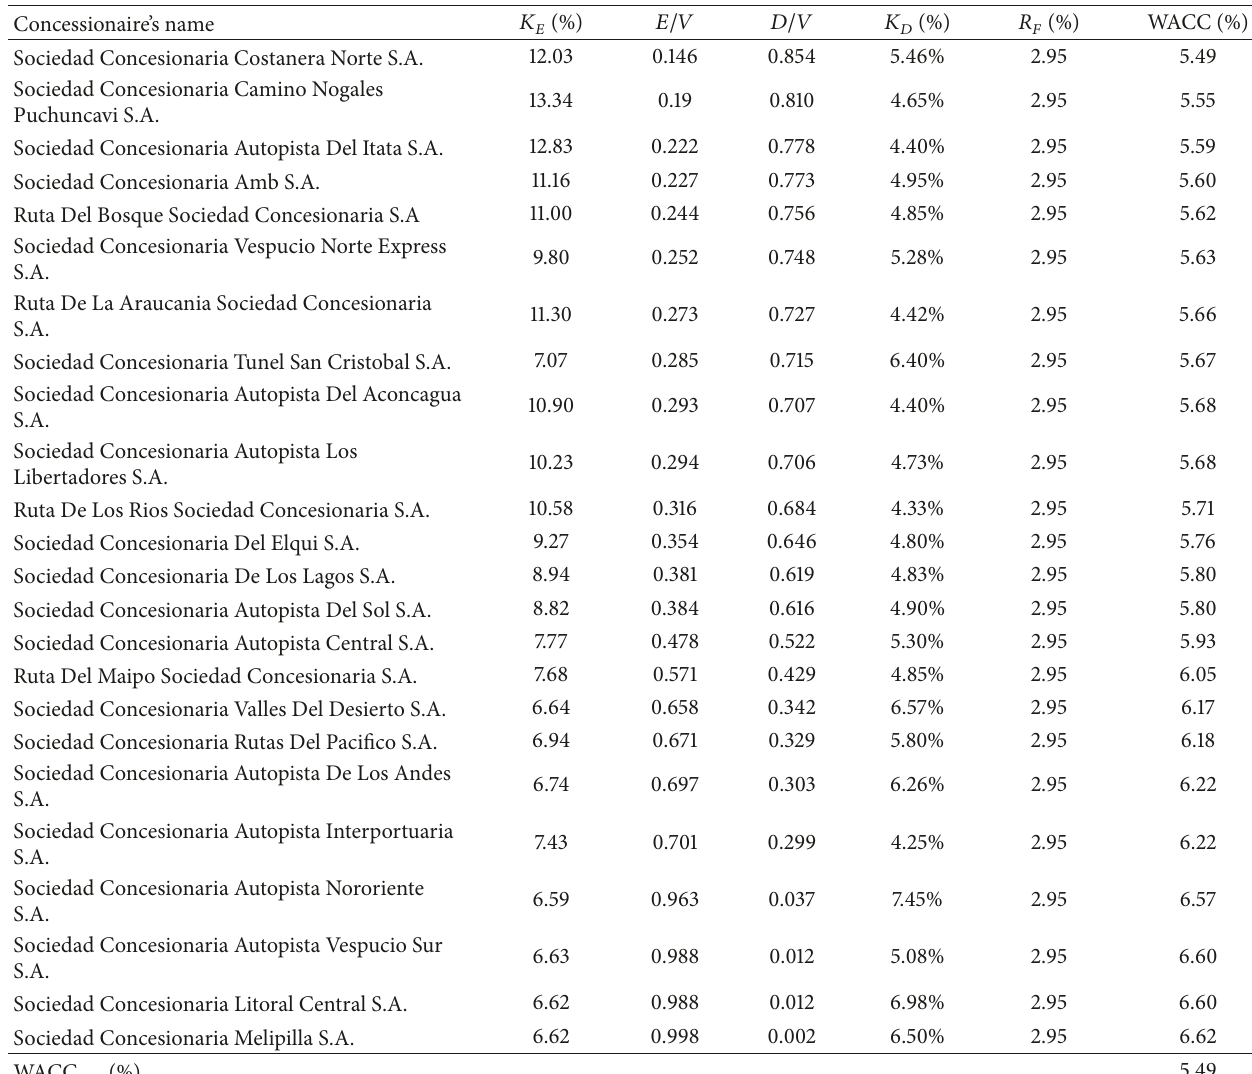
Table 6: Costs of equity and capital for Chilean highways